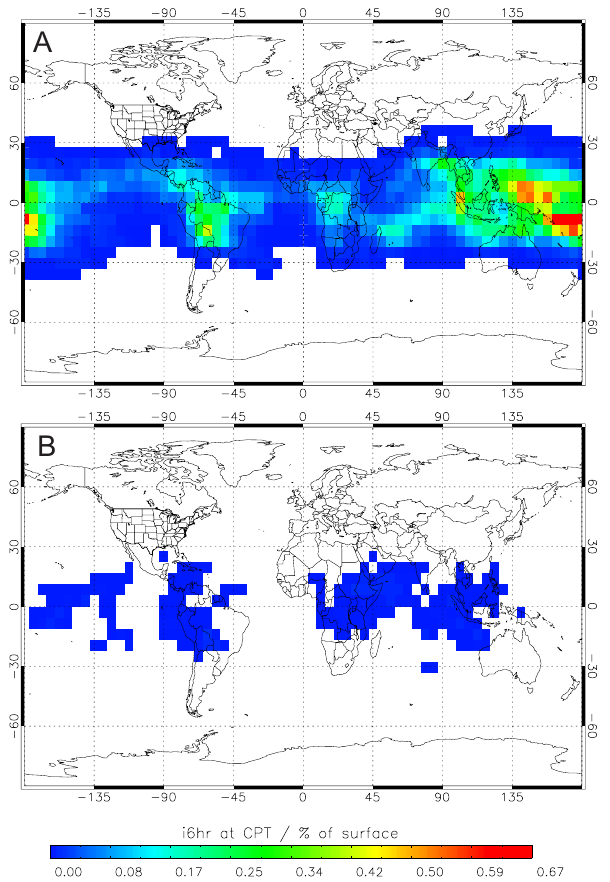
Fig. 4. Percentage (%) of the surface mixing ratio of the idealised tracer (i6hr) at the cold point tropopause from (A) S archived and (B) S diagnosed . Initial uniform surface vmr of